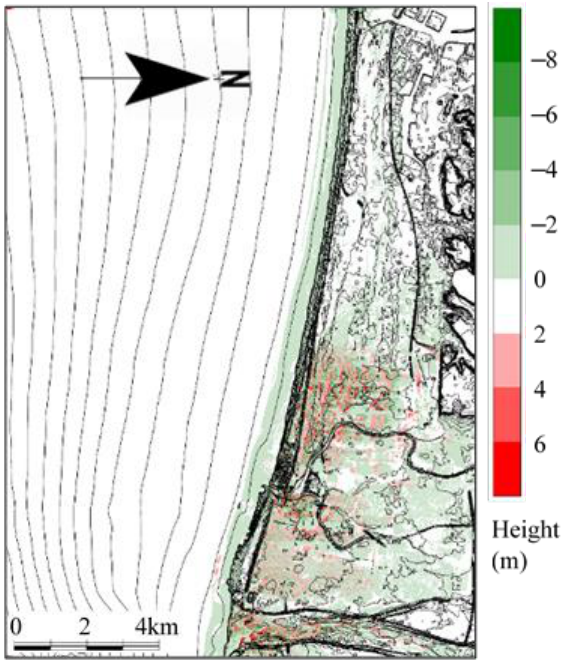
Figure 15. Topography change output 33 min after the start of calculation (present condition).